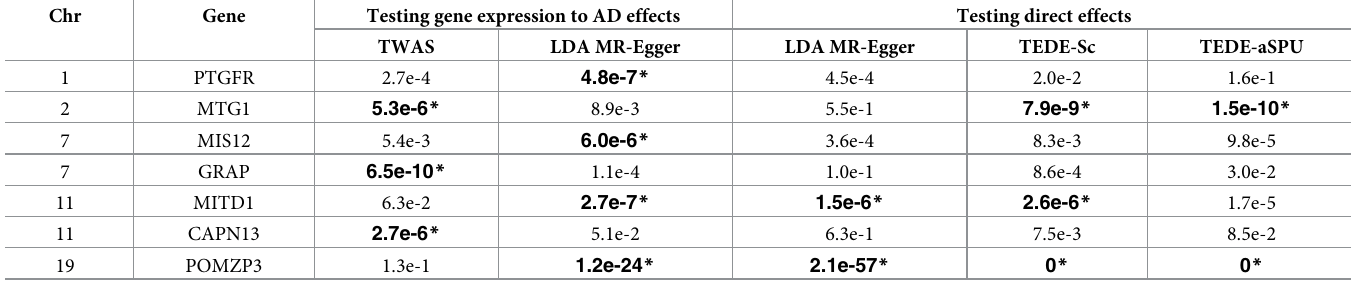
Table 6. P-values of testing gene expression to AD effects and other direct effects. 3611 loci (49225 SNPs) were tested in total. Stars indicate achieving statistical signifi- cance at Bonferroni adjusted significance threshold 1.38e-5. Chr